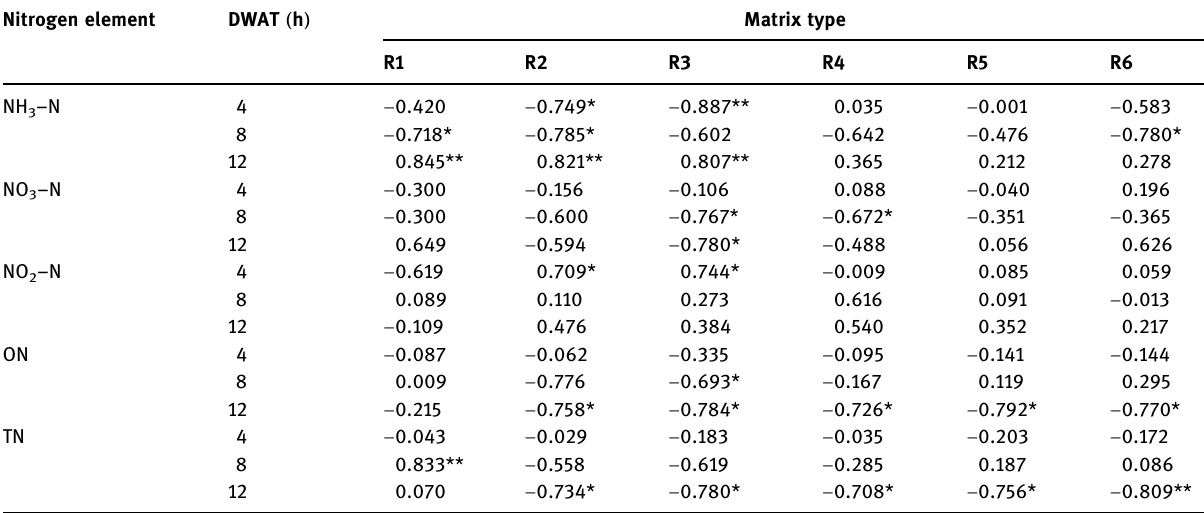
Table 3: Correlation between dry – wet alternation and nitrogen removal rate Nitrogen element DWAT ( h